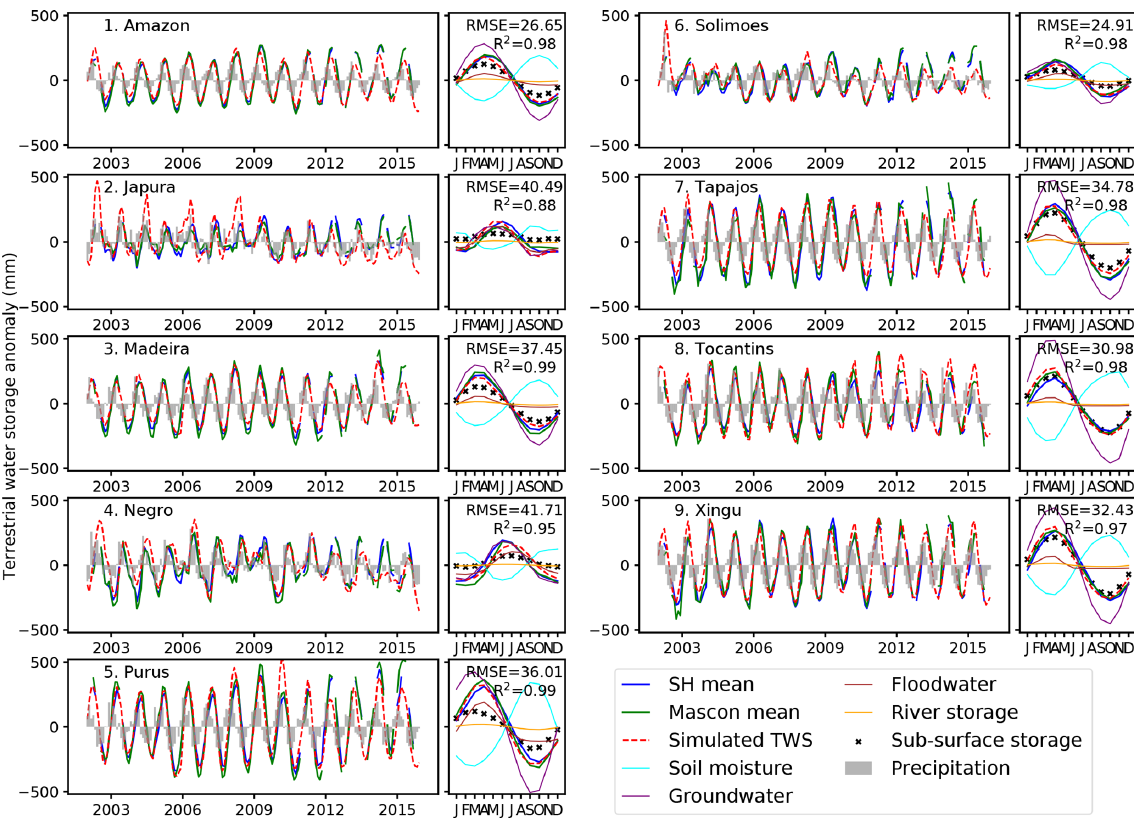
Figure 2. Comparison of simulated TWS anomalies from LHF and TWS anomalies obtained from GRACE for the entire Amazon and its eight sub-basins for the 2002–2015 period. Basin-averaged precipitation anomalies obtained from the WFDEI forcing dataset are also shown as grey bars. Seasonal cycles of GRACE and simulated TWS are shown in the right panel of each basin along with the simulated individual TWS components. GRACE results are shown as the mean of the spherical harmonics (SH) solutions from three different processing centers (i.e., CSR, JPL, and GFZ) and mascon solutions from CSR and JPL. Simulated TWS anomalies are calculated with respect to the GRACE anomaly window of 2004–2009 for